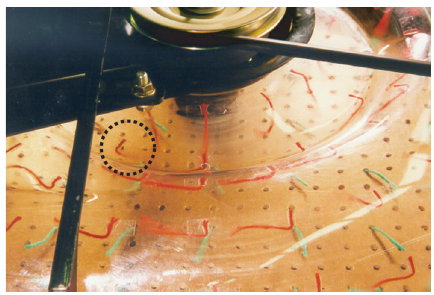
Figure 14: Tuft test view at section 2 for Model I. Table 4: Noise test result (dB).